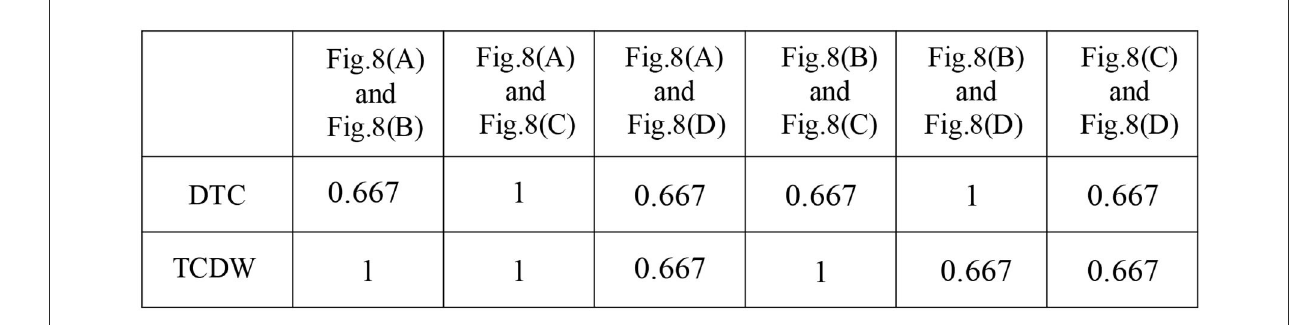
FIGURE10 Trace consistency degree measurement results by taking DTC (Weidlich et al., 2011) and TCDW